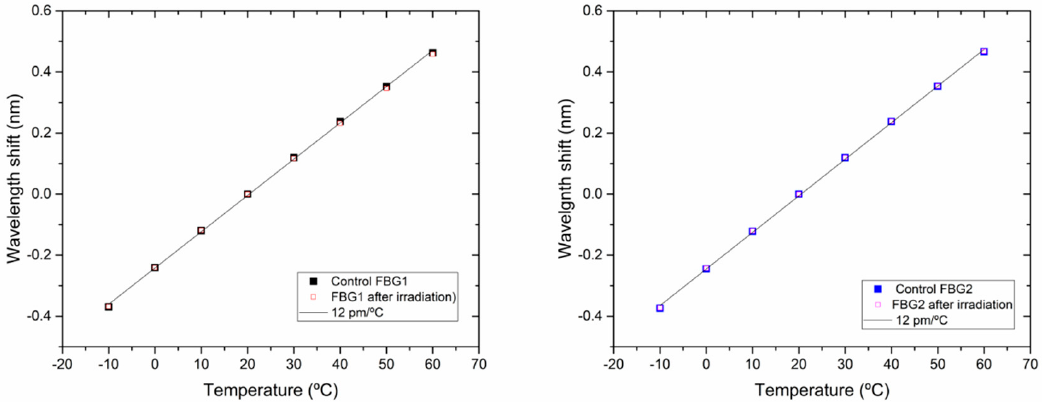
Figure 9. Wavelength shift of the Bragg wavelength when temperature changed from − 10 ◦ C to +60 ◦ C: full squares represents the data from Control FBGs; hollow squares represent the FBGs data after irradiation; left: FBG1 and Control FBG1; right: FBG2 and Control FBG2. Linear fits are represented in black lines.